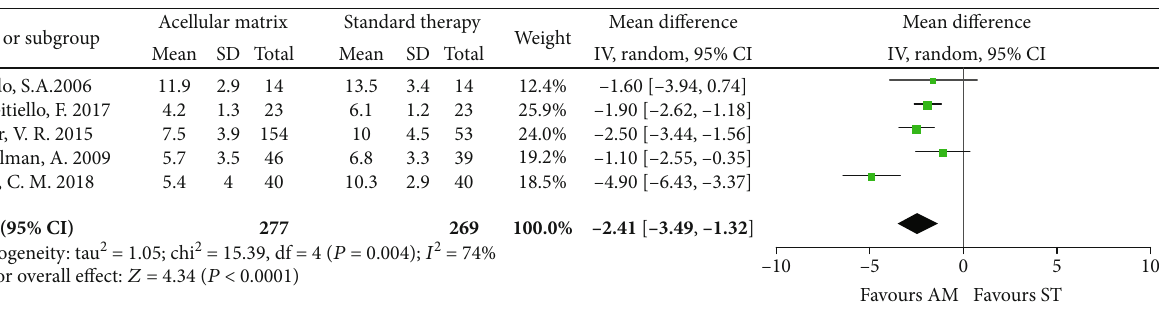
Figure 6: Forest plot of time to complete